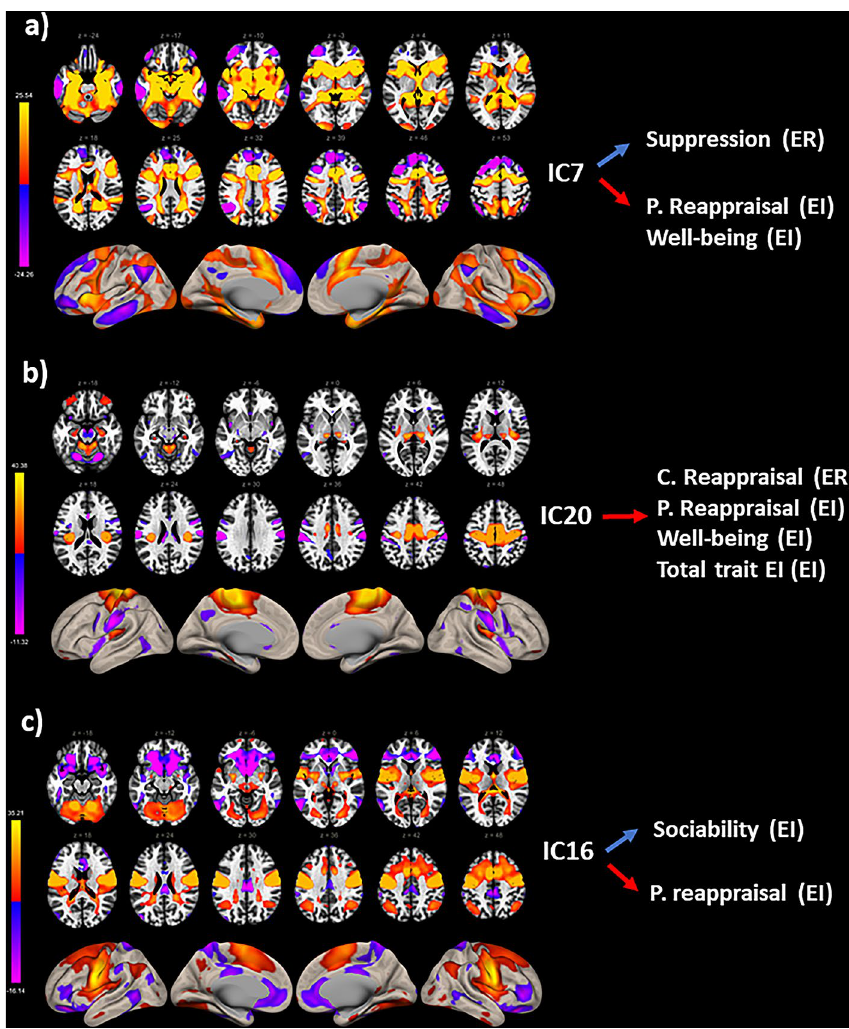
Figure 1. Representation of the ICs shared by trait EI and ER. ( a ) IC7; ( b ) IC20 and ( c ) IC16. Left of the panel: 2D (above) and 3D inflated (below) brain model for the three ICs (cluster significance p FDR < 0.05 and voxel significance pFDR < 0.001). Colour bar represents positive t- values in orange and negative t- values in blue. Right of the panel: Relation between the ICs and the subscales of trait EI and ER questionnaires. In red, the positive relation; In blue, the negative relation. C. Reappraisal cognitive reappraisal, P. Reappraisal positive